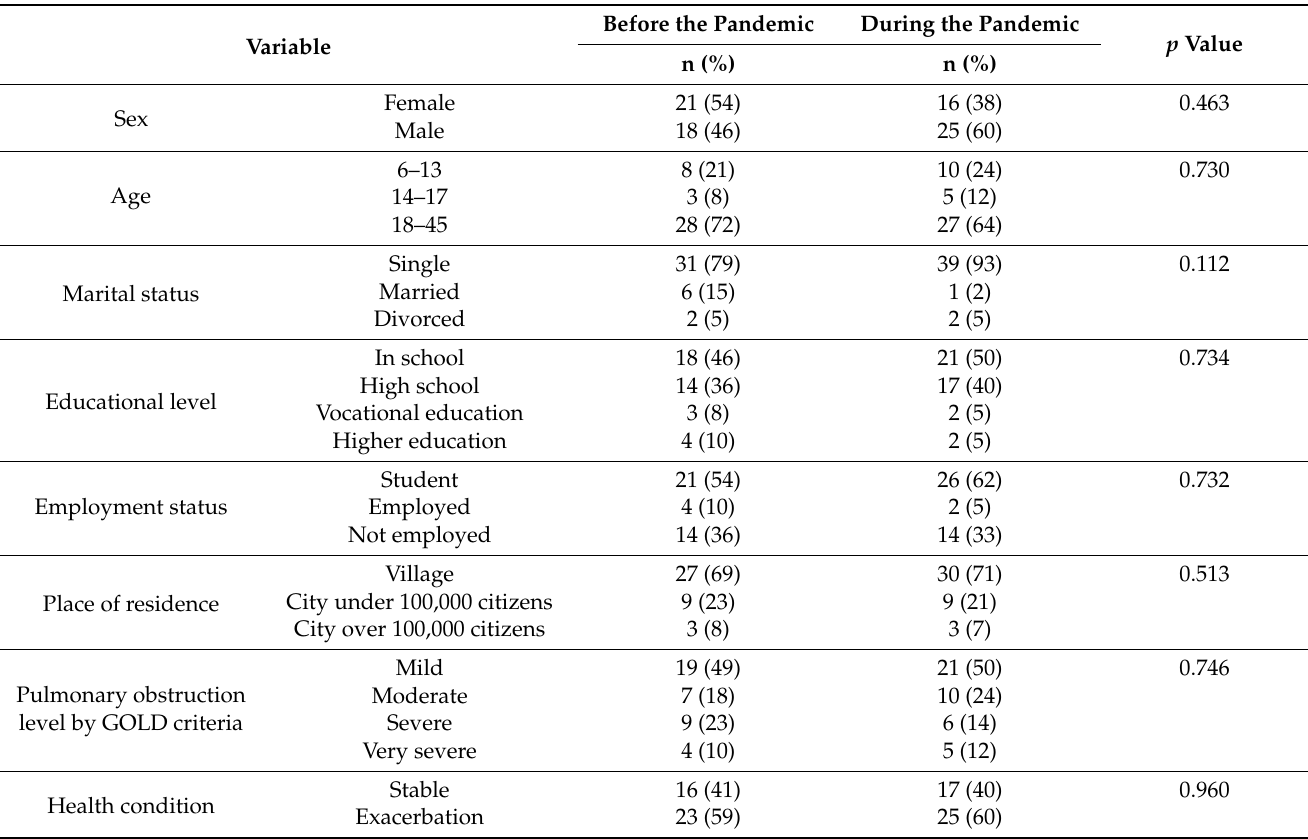
Table 1. Sociodemographic data of surveyed patients.